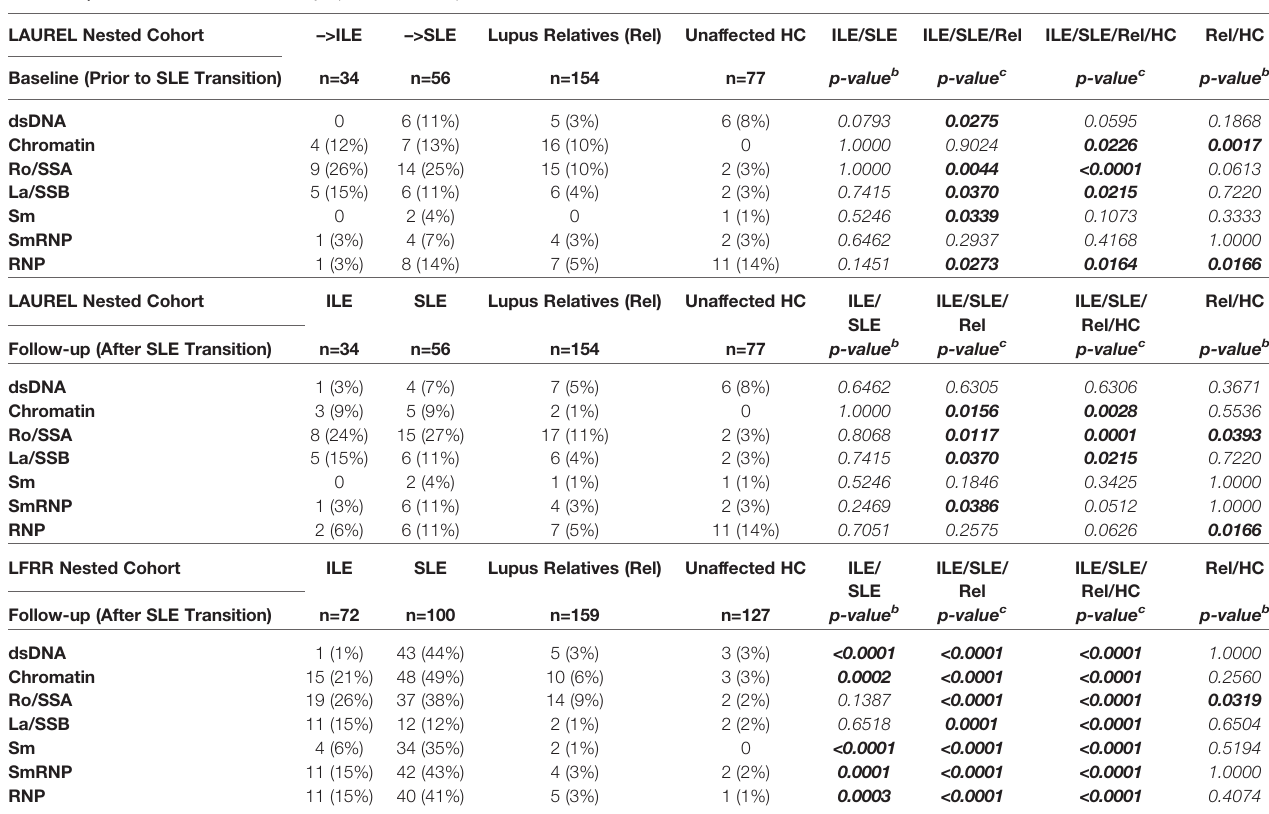
TABLE 8 | SLE-Associated Autoantibody Speci fi cities in Lupus Relatives Who Transition to ILE or SLE a . LAUREL Nested Cohort – >ILE – >SLE Lupus Relatives (Rel) Unaffected HC ILE/SLE ILE/SLE/Rel ILE/SLE/Rel/HC Rel/HC Baseline (Prior to SLE Transition) dsDNA